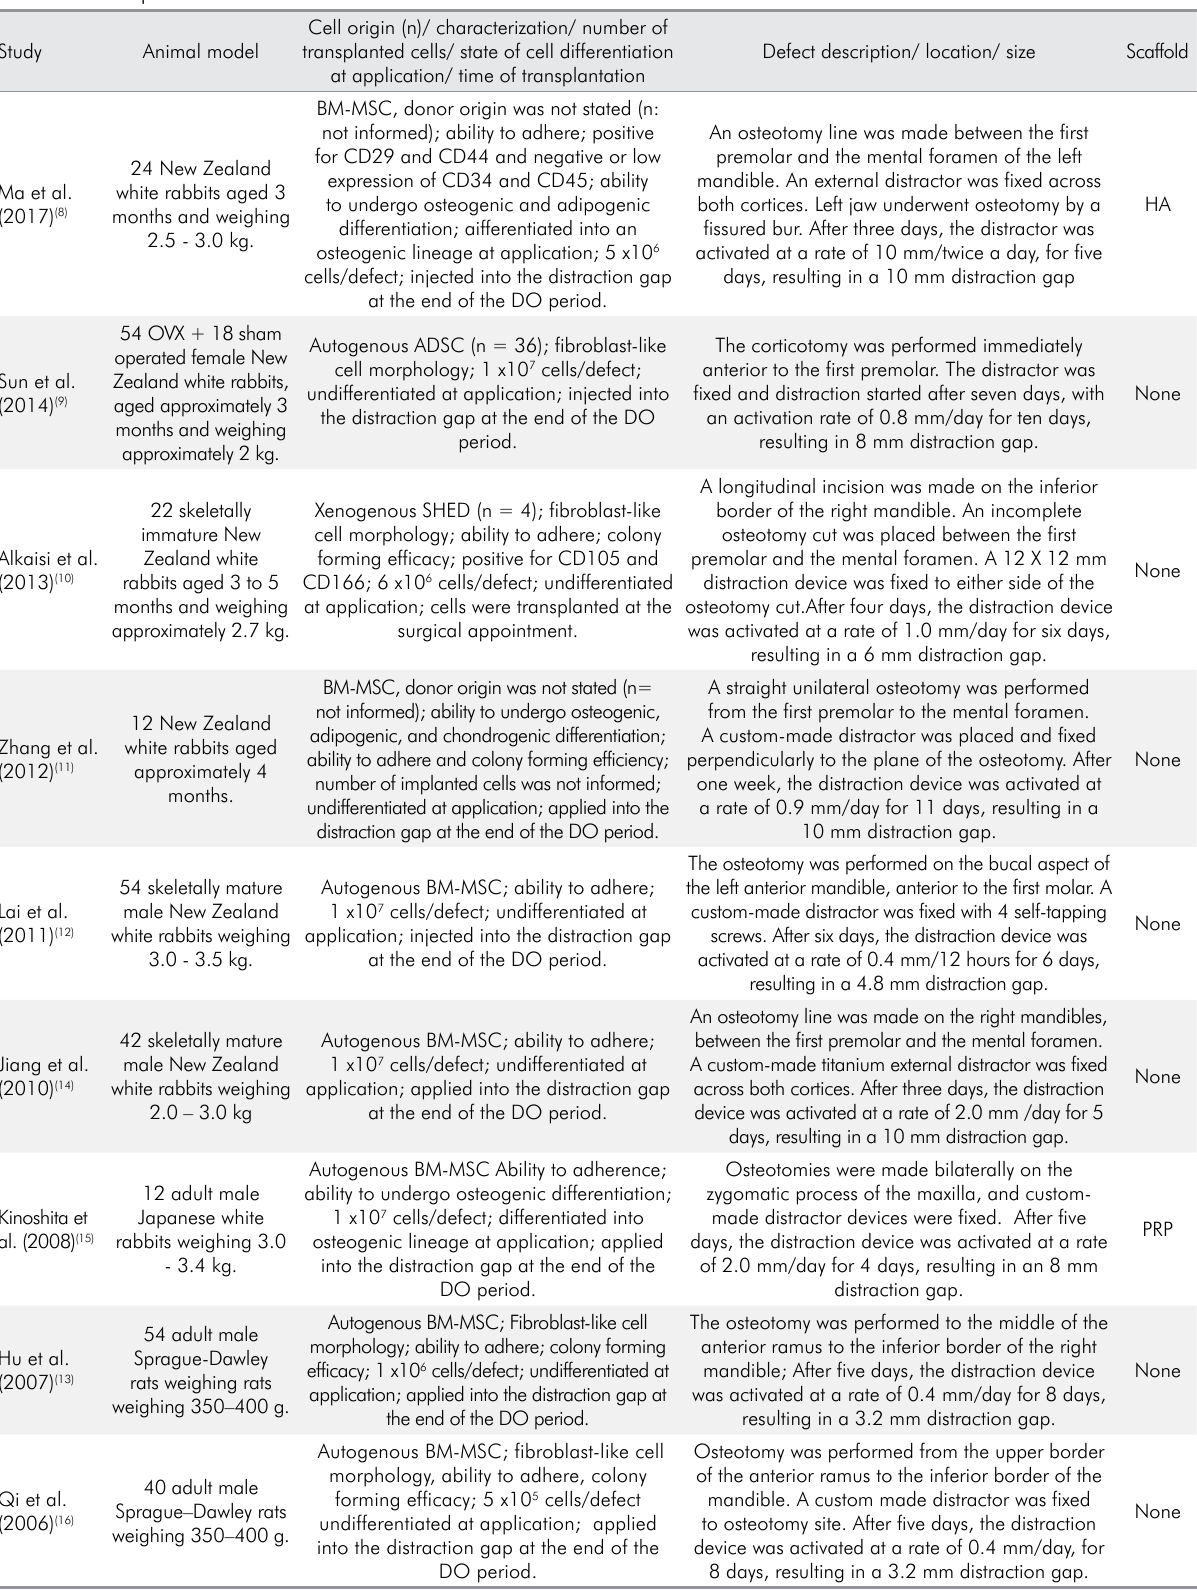
Table 2. Description of the models used in the included studies.